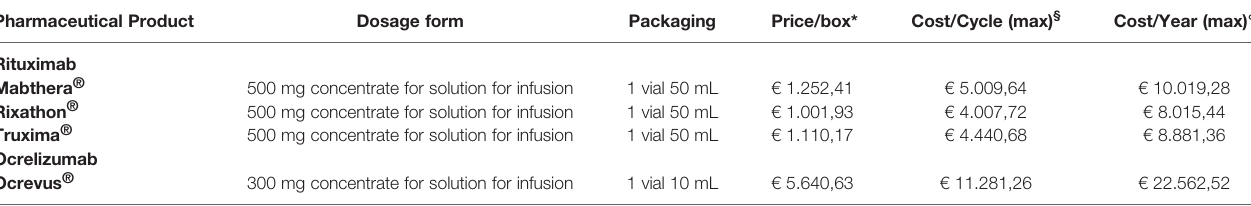
TABLE 3 | Estimated expenditure for anti-CD20 in MS in